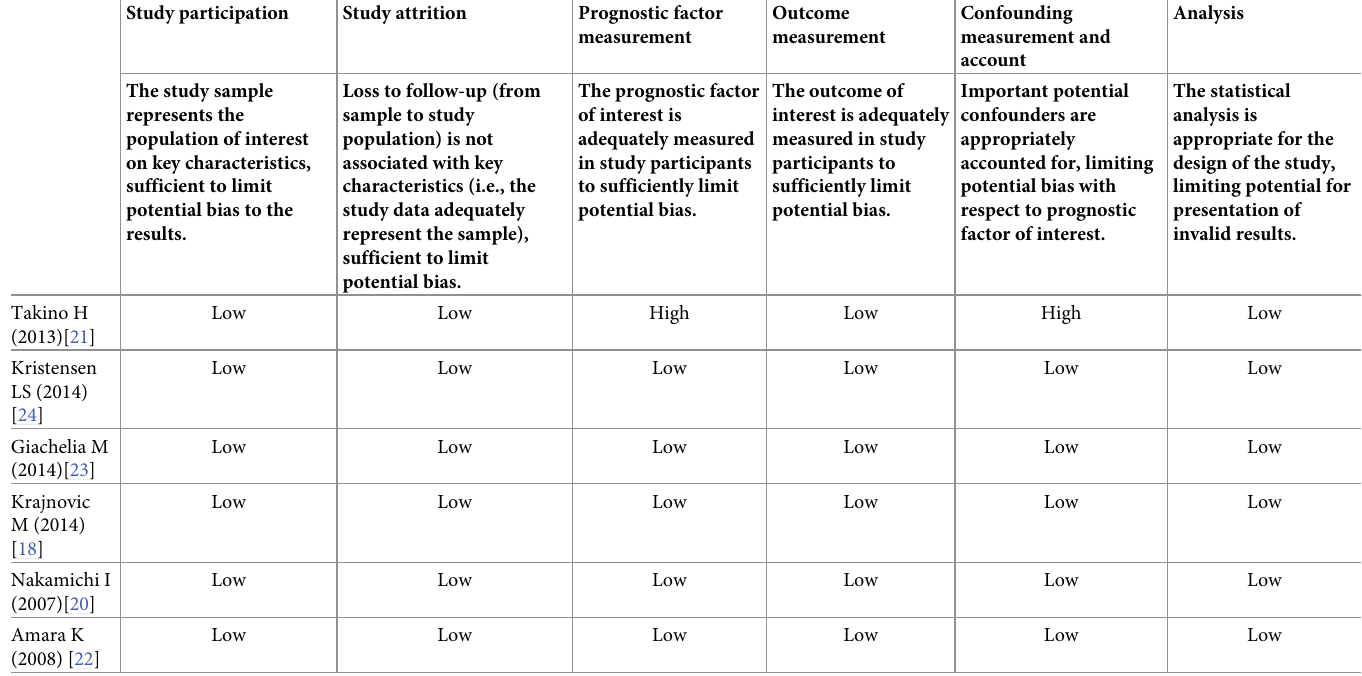
Table 3. Quality assessment of the included studies based on the quality in Prognosis Studies